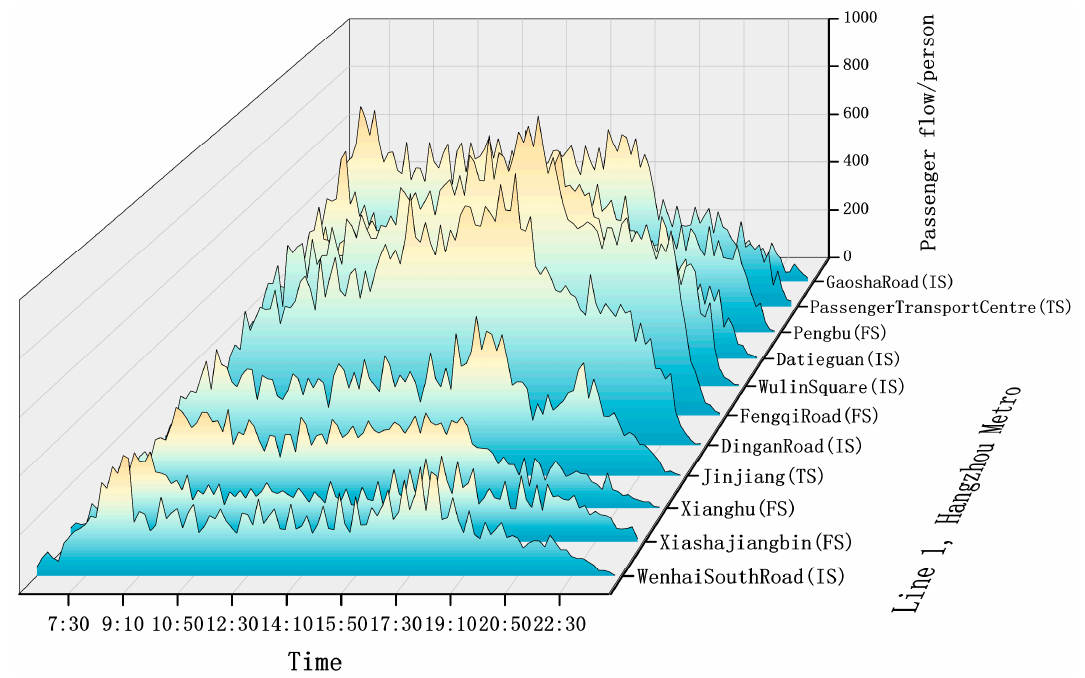
Figure 3. Passenger flow of Hangzhou Metro Line 1 at different stations. FS: first station, LS: last station, TS: transit station, IS: intermediate station (not FS, LS, or